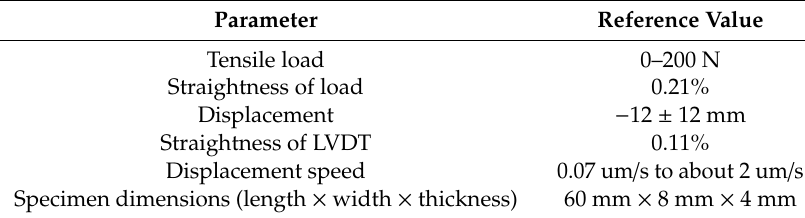
Table 1. Main performance parameters of the tensile machine.